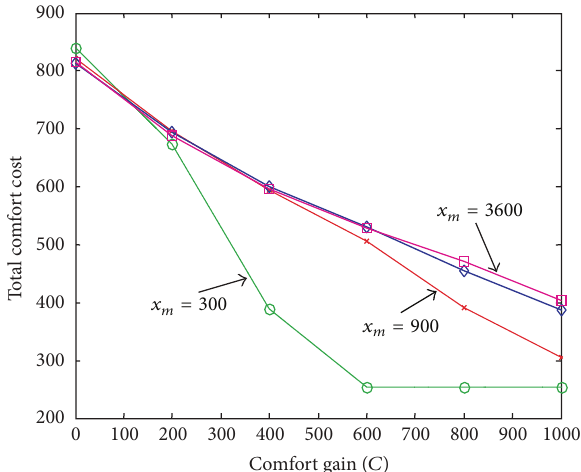
Figure 12: Total comfort cost for Pareto distributed occupation period.